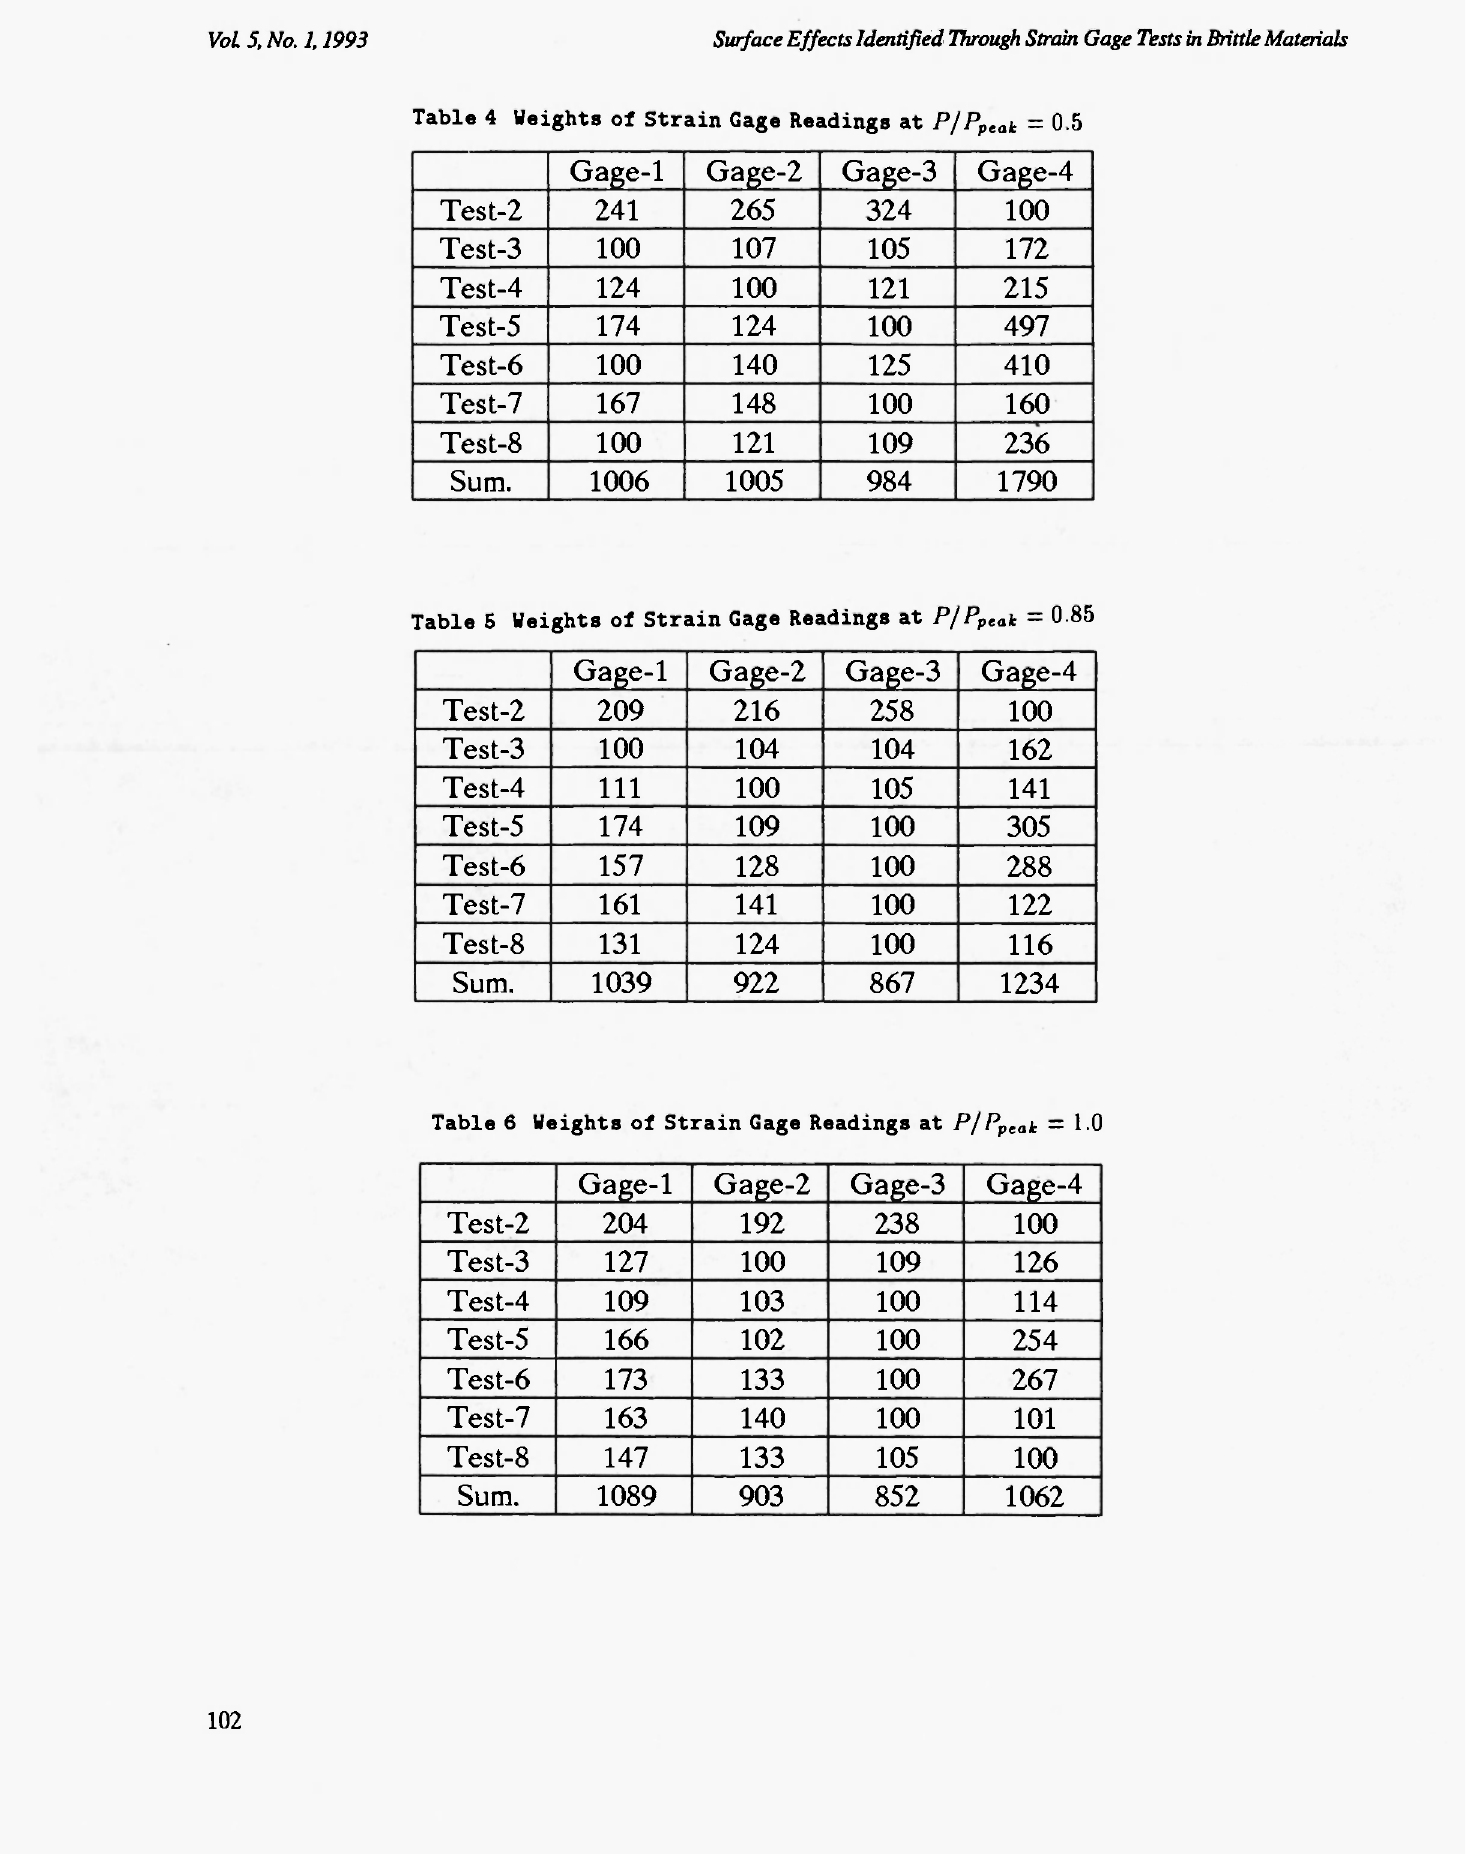
Table 4 Weights oi Strain Gage Readings at P/P peak = 0.5